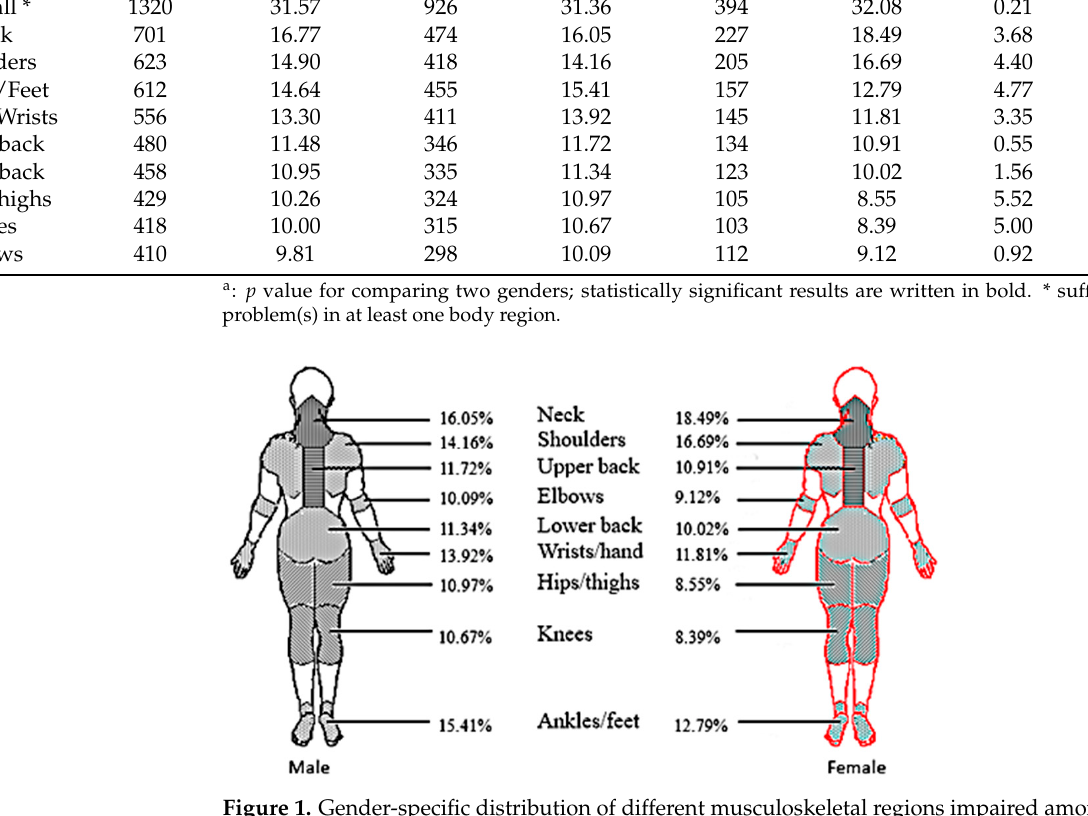
Figure 1. Gender-specific distribution of different musculoskeletal regions impaired among furniture manufacturing workers. Male workers are shown in black and female workers are shown in red. Table 3. The adjusted odds ratios (95% CI) of the risk factors for WMSDs in the neck, trunk, hands/wrists, and